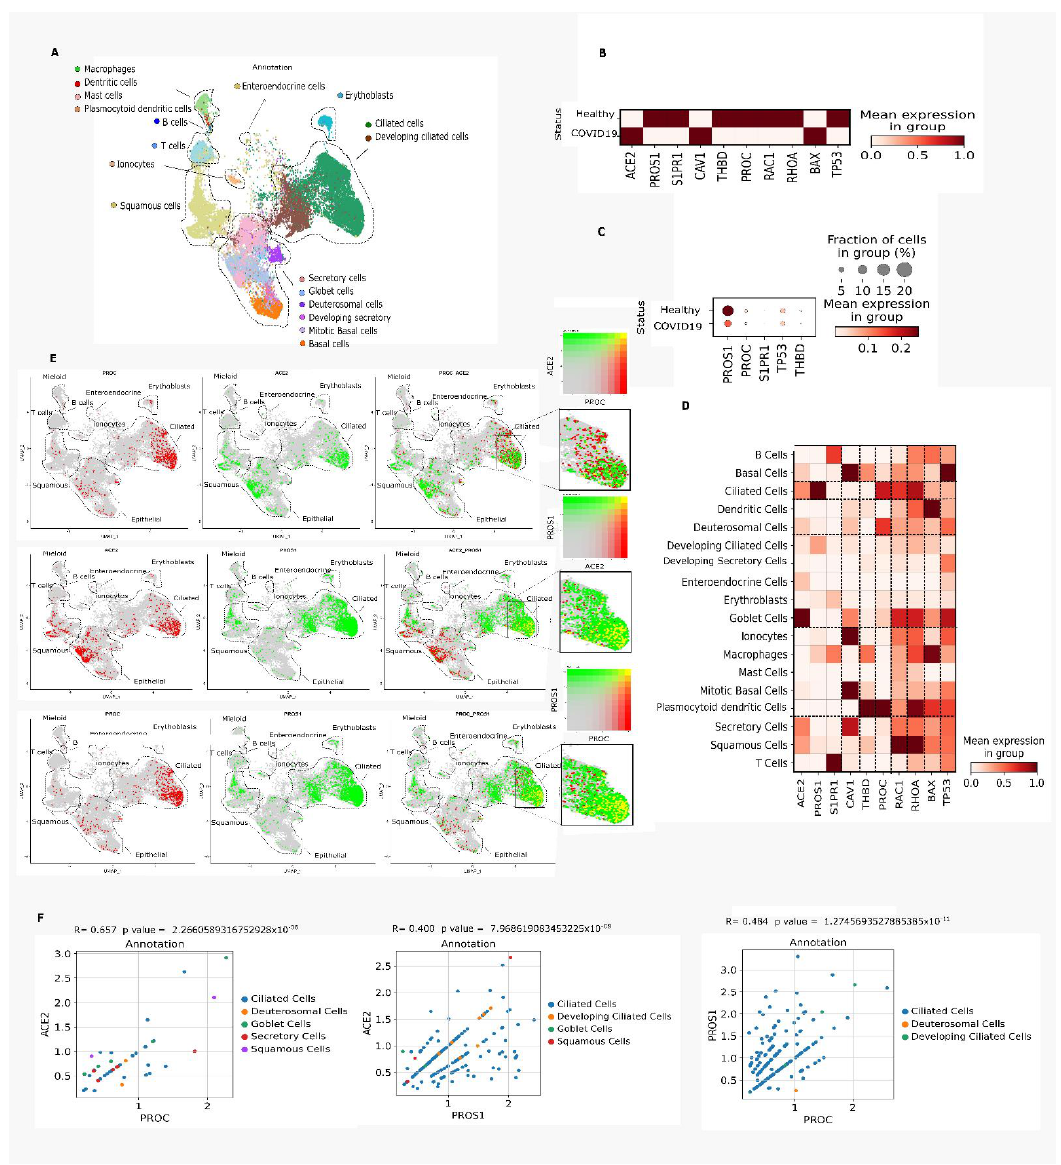
single-cell transcriptomics. ( A ). Matrix plot showing expression of genes related to APC signaling in patients with COVID-19 versus healthy individuals. ( B ). Dot plot representation of downregulated genes in patients with COVID-19. ( C ). Matrix plot showing expression of the main genes related to APC signaling according to cell types.